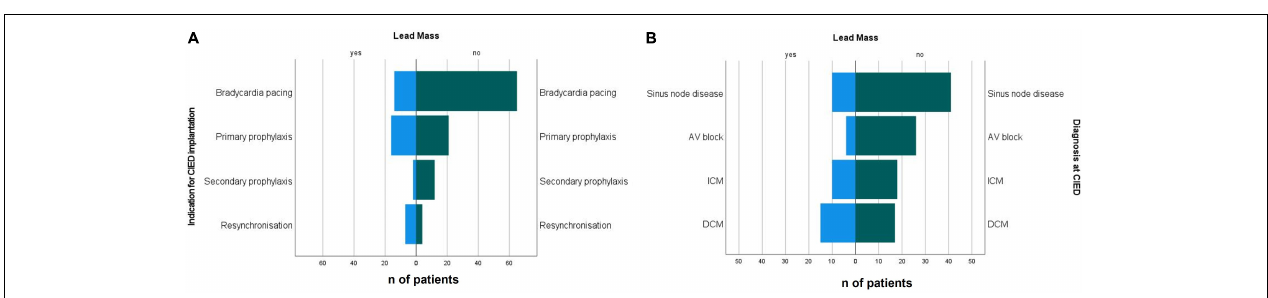
FIGURE 3 | (A) Presence of defibrillation lead and (B) CIED type in patients with with incidental non-infectious CIED lead masses and non-suspicious leads. CIED, cardiac implantable electronic device; PM, pacemaker; ICD, implantable cardioverter defibrillator; CRTP, cardiac resynchronisation therapy device -pacemaker; CRTD, cardiac resynchronisation therapy device–defibrillator.